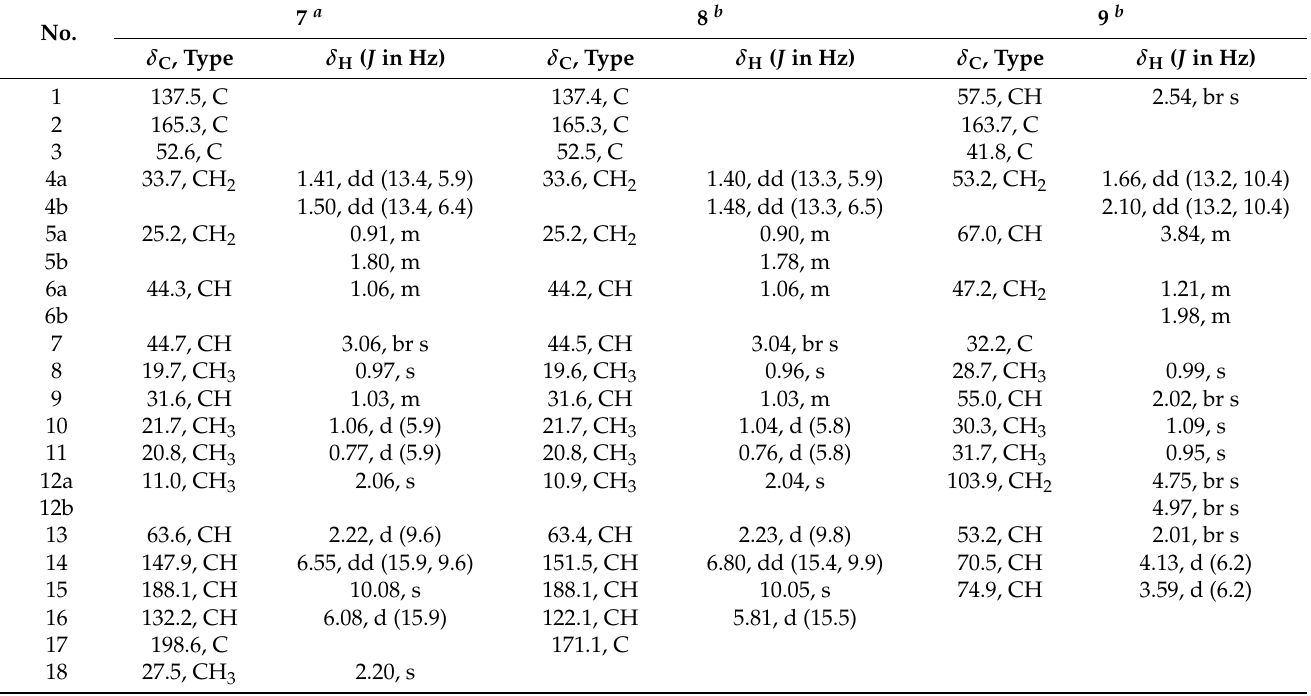
Table 3. 1 H (600 MHz) and 13 C (150 MHz) NMR Spectroscopic Data for 7 – 9 .